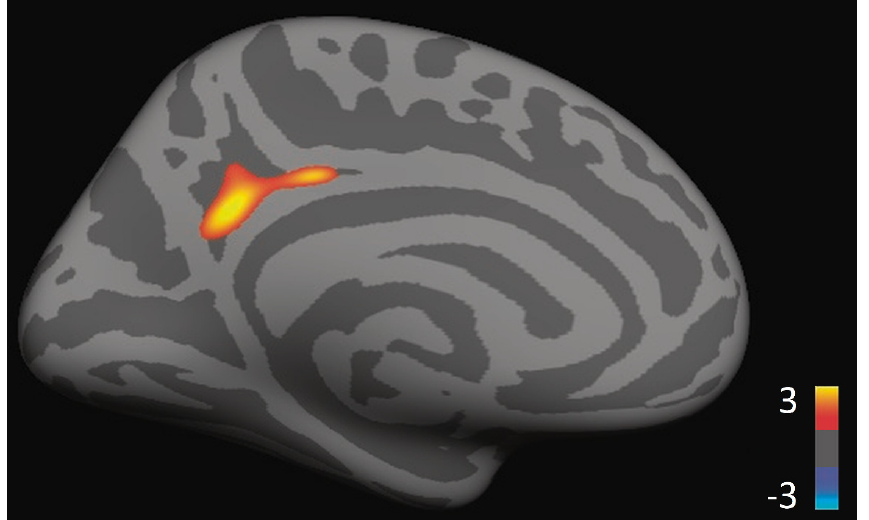
Figure 2. Ego development correlates with cortical thickness in the PCC/precuneus in the overall sample ( p = 0.0237).